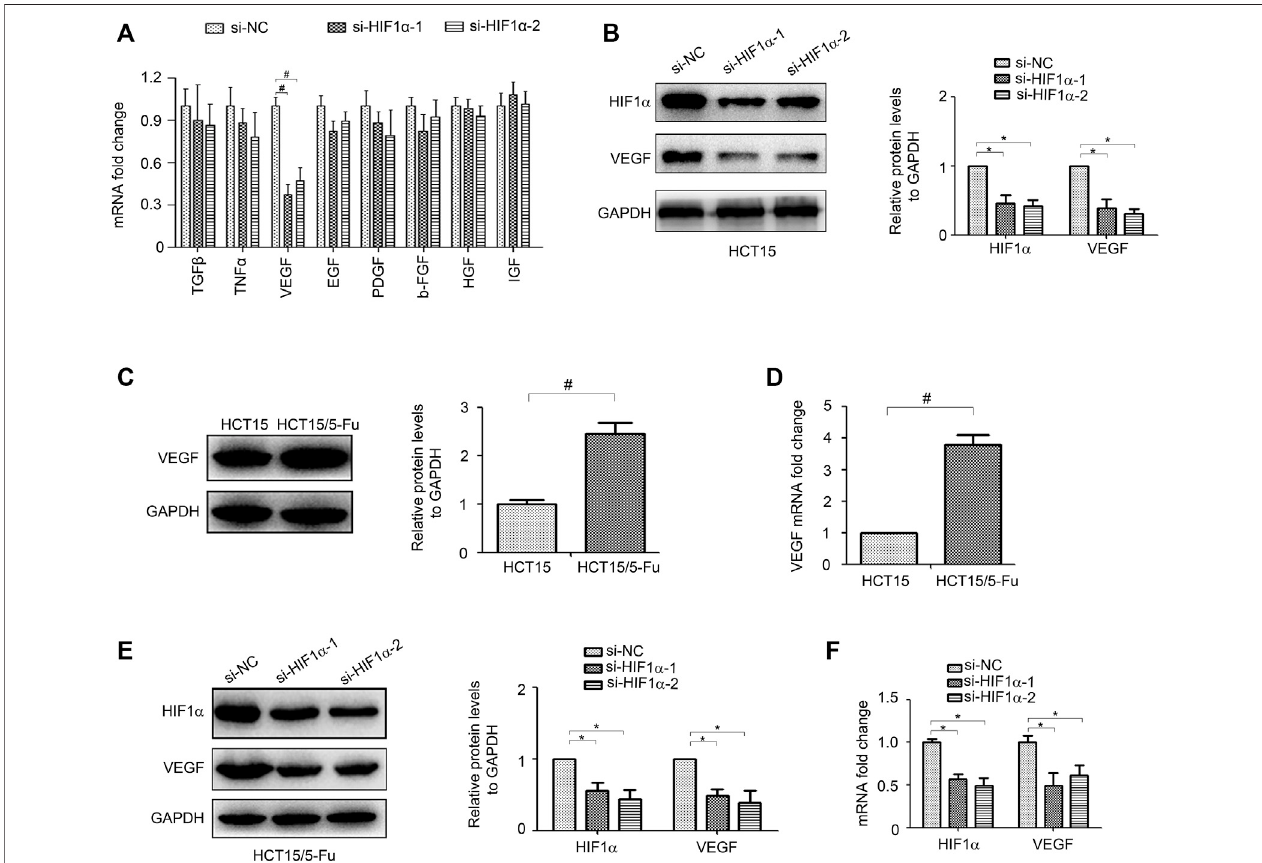
FIGURE 4 | HIF1 α regulates VEGF expression in CRC cells. (A) the mRNA expression of TGF- β , TNF- α , VEGF, EGF, PDGF, b-FGF, HGF, and IGF in HCT15 cells transfectedwithsi-NCorsi-HIF1 α for48 hweredetectedbyRT-PCR. (B) theproteinexpressionofVEGFinHCT15cellstransfectedwithsi-NCorsi-HIF1 α for48 hwere detected by WB. (C,D) the mRNA and protein expression of VEGF in HCT15 and HCT15/5-Fu cells were detected by WB and RT-PCR, respectively. (E,F) the mRNA and protein expression of VEGF in HCT15/5-Fu cells transfected with si-NC or si-HIF1 α for 48 h were detected by WB and RT-PCR, respectively. #: p < 0.01, *: p <